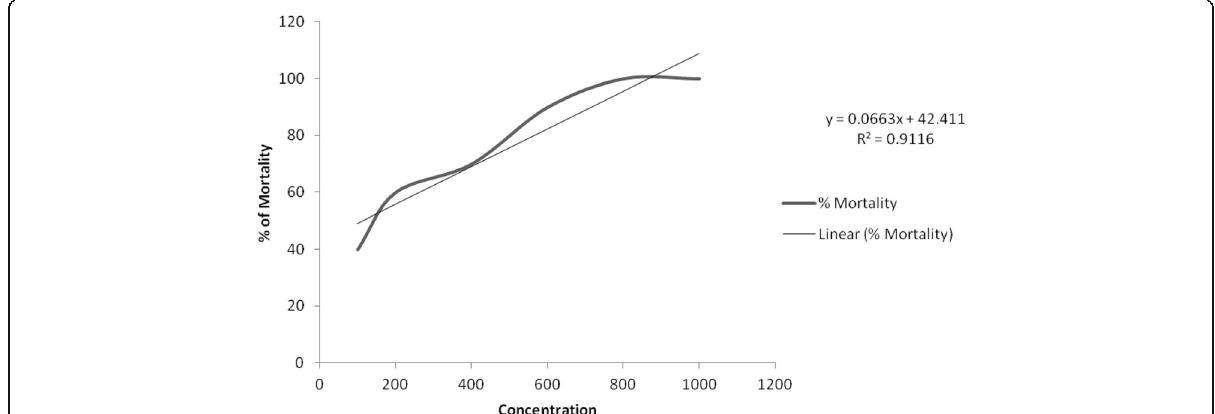
Fig. 3 Cytotoxic effect of EETI in brine shrimp nauplii . Effects of various concentrations of ethanol extract of T. integrifolia rhizomes on the viability of brine shrimp nauplii after 24 h incubation. Percentage mortality of brine shrimps of ethanolic extract of rhizomes of T. integrifolia. Data are shown as mean ± SEM of 10 shrimps for each concentration